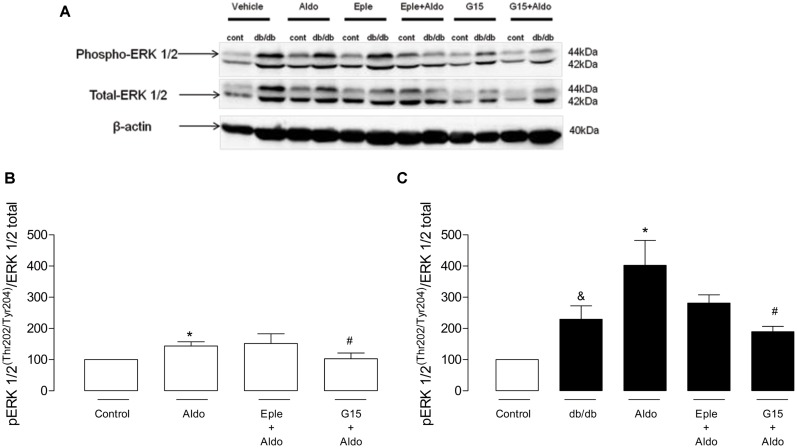
Aldosterone increases vascular ERK 1/2 phosphorylation in control and db/db mice. (A) Representative blots of phospho-ERK1/2, total ERK1/2, and b-actin. The effects of G15 (1 μM) and eplerenone (10 μM) on aldosterone (10 nM)-stimulated ERK1/2 phosphorylation in MA in control (B) and db/db
(C) mice are also shown. Data represent the mean ± SEM from three independent experiments. (∗), (&), and (#) (p < 0.05) vs. control, control aldosterone, and db/db aldosterone, respectively.